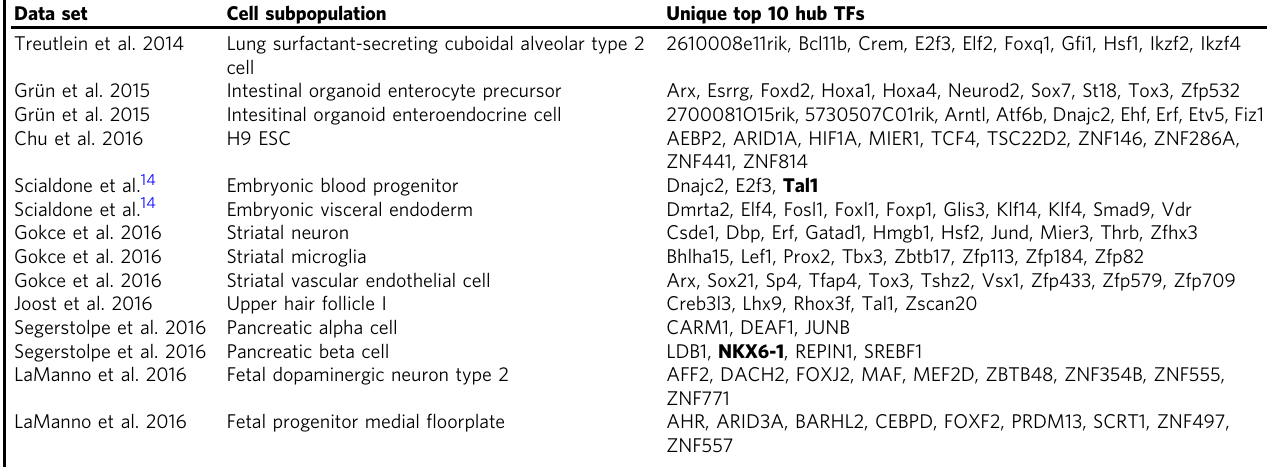
Table 2 Unique top 10 hub TFs in GRNs for the example subpopulations in Table 1. Known identity TFs are in bold. Data